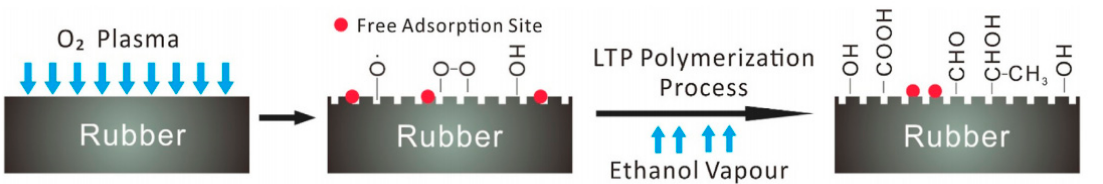
Figure 7. Treatment steps related to the low temperature plasma (LTP) process to modify the GTR surface (reproduced with permission from [77]) .